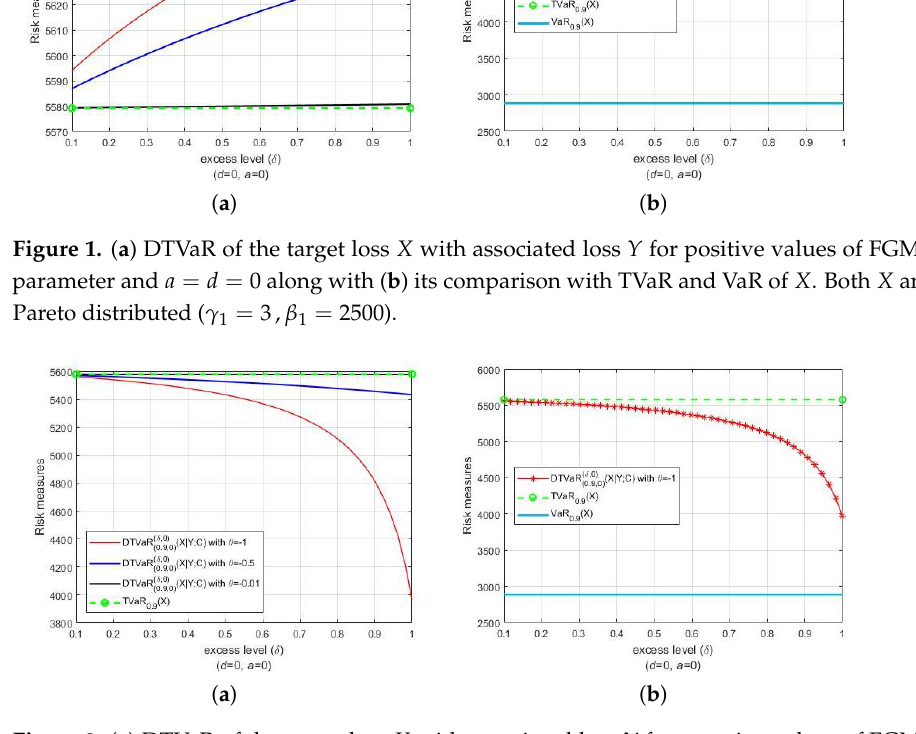
Figure 2. ( a ) DTVaR of the target loss X with associated loss Y for negative values of FGM copula parameter and a = d = 0 along with ( b ) its comparison with TVaR and VaR of X . Both X and Y are Pareto distributed ( γ 1 = 3, β 1 =